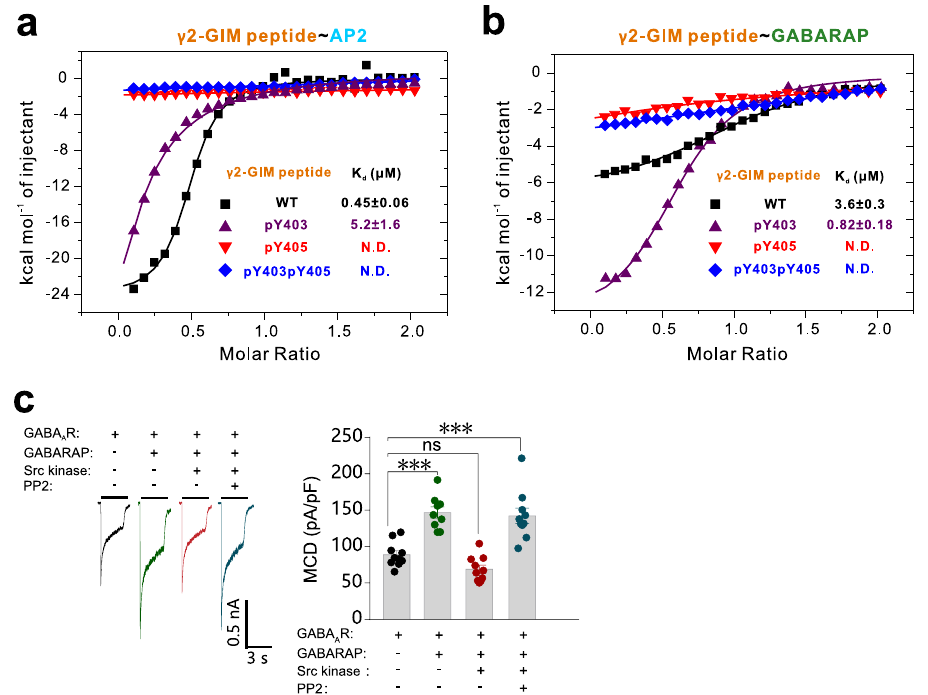
Fig. 6 Differential phosphorylation modulates the capacity of GABA A receptor γ 2 subunit to interact with GABARAP vs. the clathrin adaptor protein AP2. a ITC-derived binding curves comparing binding af fi nities between AP2 and a synthesized γ 2-GIM WT peptide or 3 phopho-peptides (pY403, pY405, and pY403pY405). b ITC-derived binding curves comparing binding af fi nities between GABARAP and the synthesized γ 2-GIM WT peptide or 3 phopho- peptides (pY403, pY405, and pY403pY405). c Effects of Src kinase on GABA A R-mediated current densities in HEK-293 cells co-expressing GABARAP. Representative trace records and average values of GABA currents activated by 1 mM GABA in HEK-293 cells co-expressing GABA A R ( α 1 β 2 γ 2), GABARAP, and Src kinase with or without treatment of kinase inhibitor PP2. n = 10, 9, 10, and 10 of each group (from left to right). Data are represented as the mean ± SEM. *** P = 0.0001, GABA A R vs. GABA A R + GABARAP; *** P = 0.0001, GABA A R vs. GABA A R + GABARAP + Src kinase + PP2 based on one-way ANOVA; ns not signi fi cant ( P >